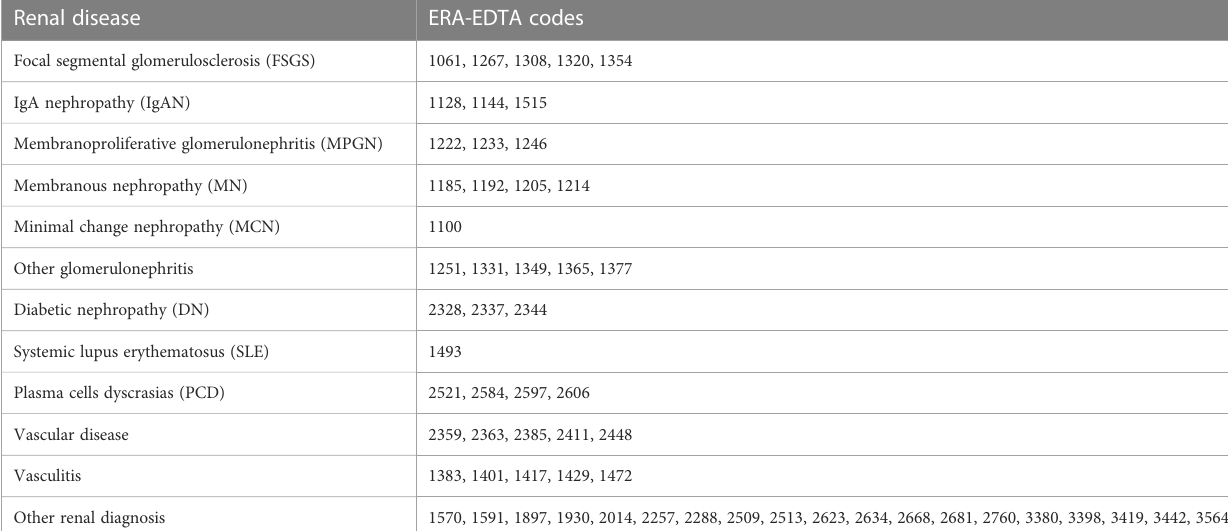
TABLE 1 Grouping of renal disease and ERA-EDTA diagnosis codes. Renal